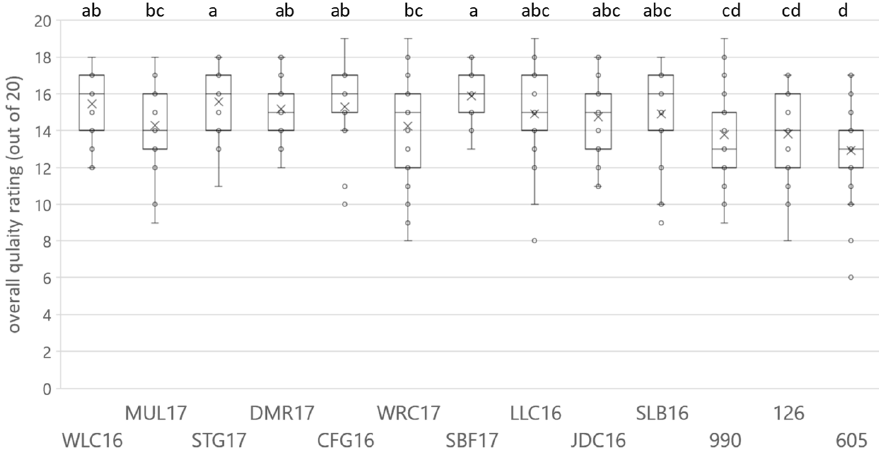
Figure 2. Box-and-whiskers plot illustrating the ANOVA results obtained for the overall quality rating for the Chenin Blanc wines evaluated, including individual rating and mean marker. Letters indicate significant differences ( p < 0.05). The codes are as specified in the text.